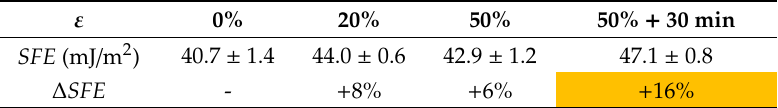
Table 6. Results of surface free energy tests for deformed polymers.